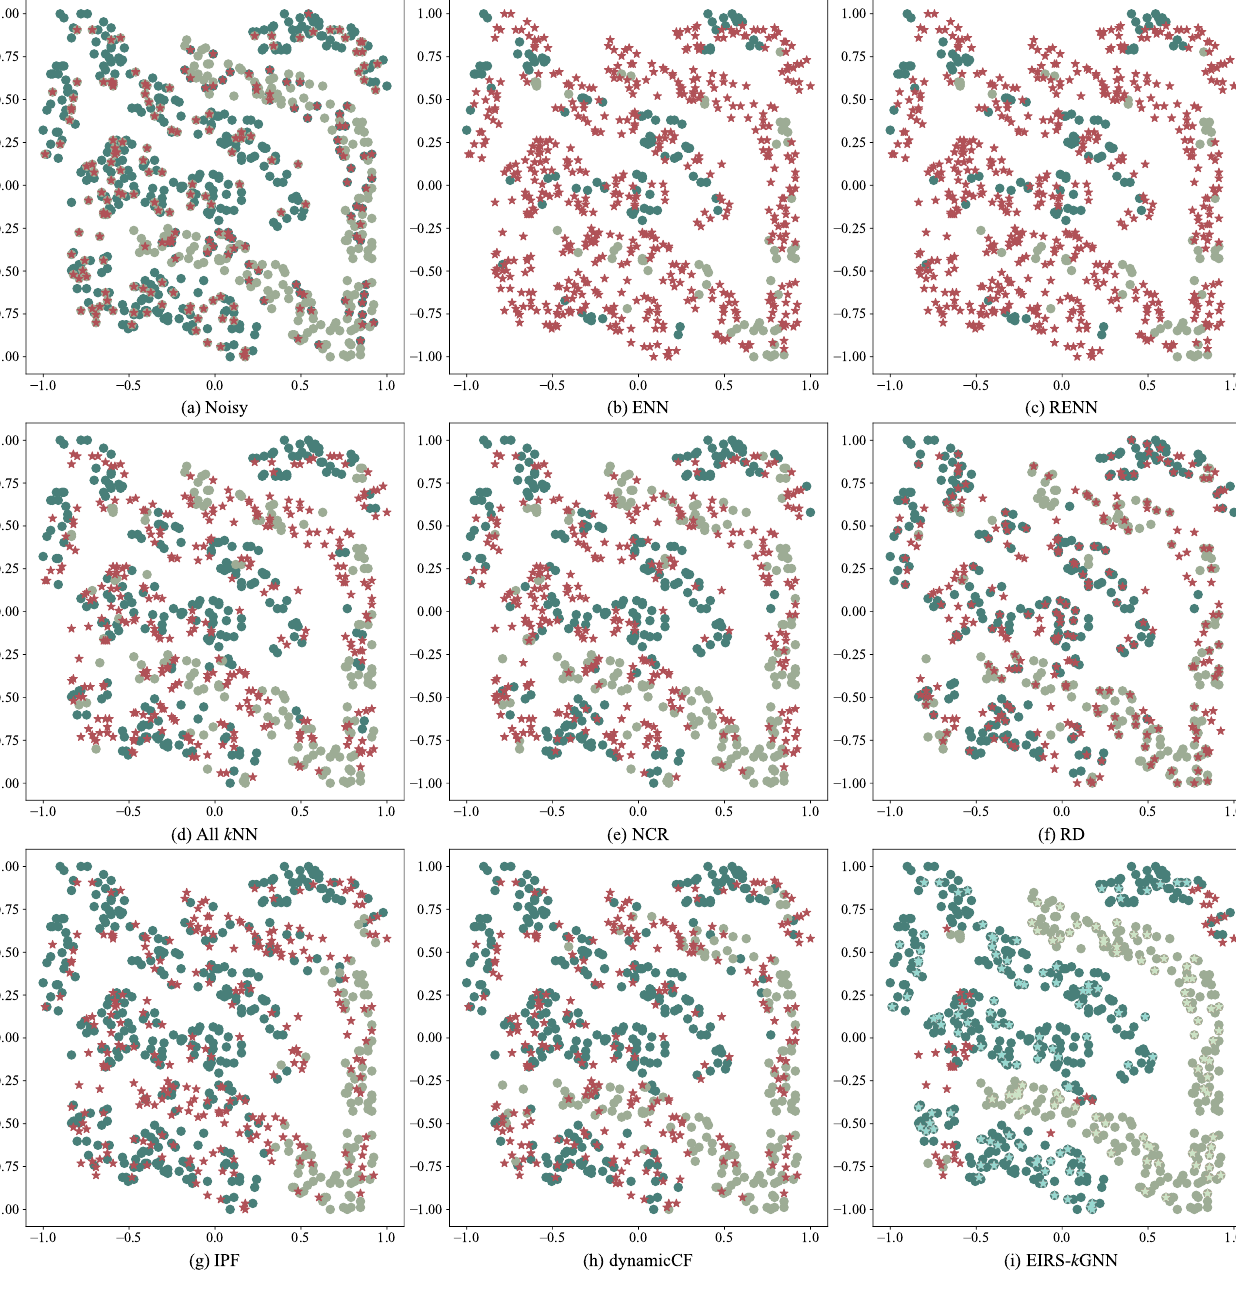
Figure 5. Different performances of various editing methods on the fourclass data